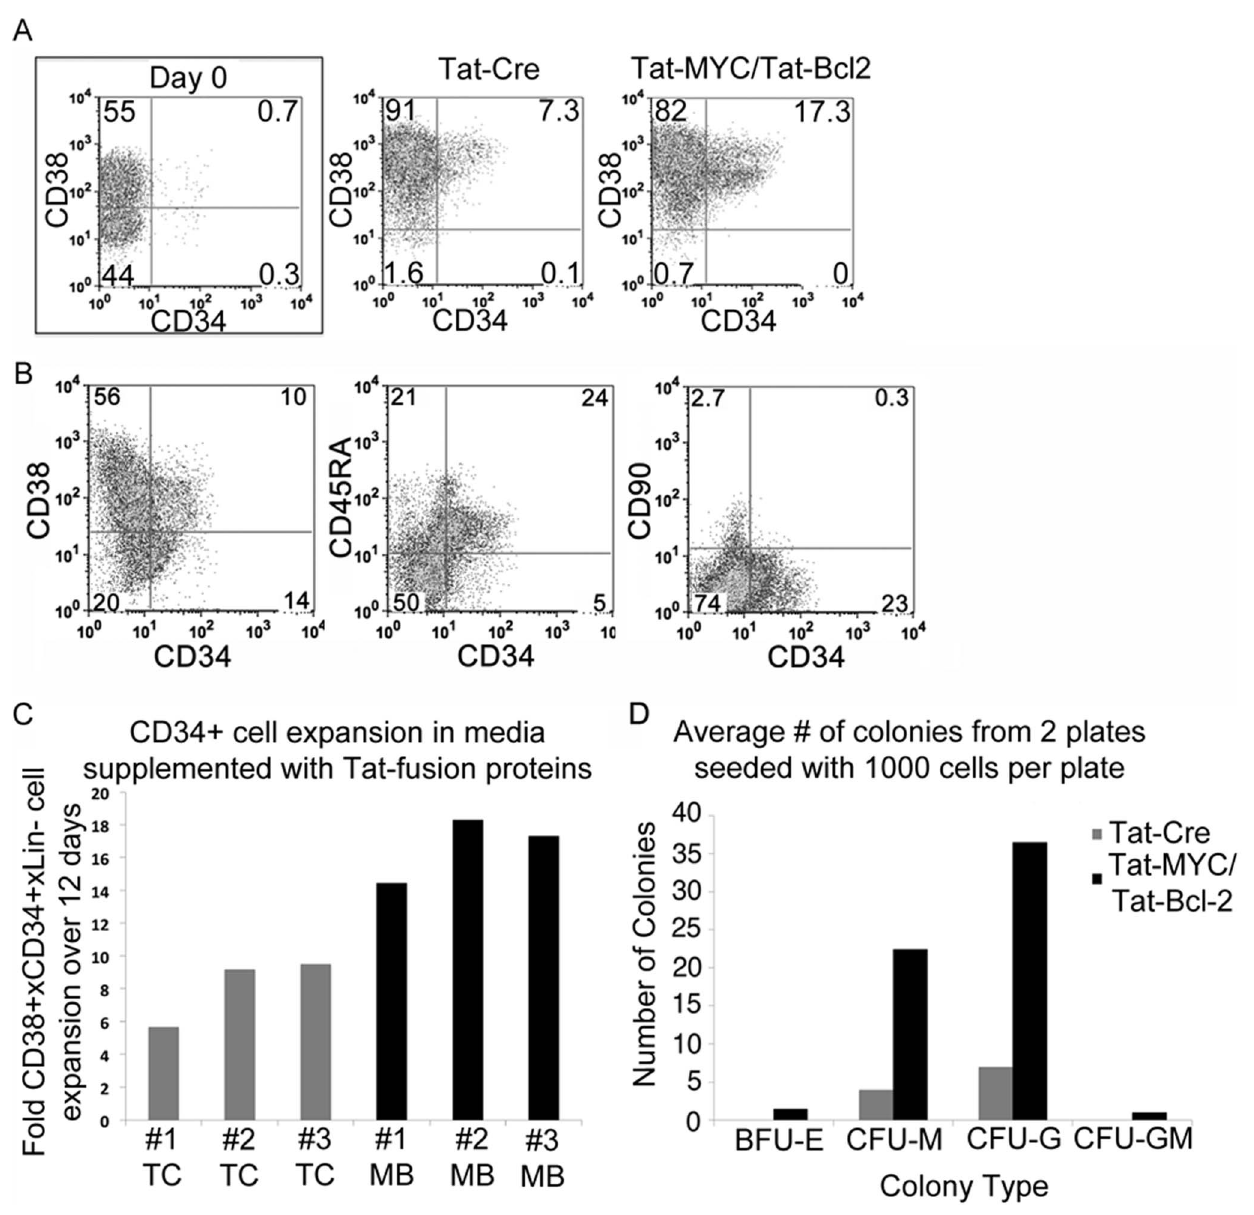
Figure 4. Expansion of human cord blood HSPCs with Tat-MYC/Tat-Bcl-2. Human cord blood cells were cultured ex vivo in CB media supplemented with Tat-Cre or Tat-MYC/Tat-Bcl-2. A. CD34 and CD38 cell surface phenotype of the human cord blood cells was assessed on Day 0 (1 st panel) or after expansion ex vivo for 12 days. B. Expanded CD34 + cells (1 st panel) were assessed for CD45RA (2 nd panel) and CD90 (3 rd panel). C. Graphical representation of the CD34 + cell expansion from three independent CB units. Each cord was split in half and treated with Tat-Cre (gray bars) or Tat-MYC/Tat-Bcl-2 (black bars). D. Quantification of each colony type that was observed in methylcellulose cultures seeded with 10 3 cord blood cells cultured in CB media supplemented with Tat-Cre (gray bar) Tat-MYC/Tat-Bcl-2 (black